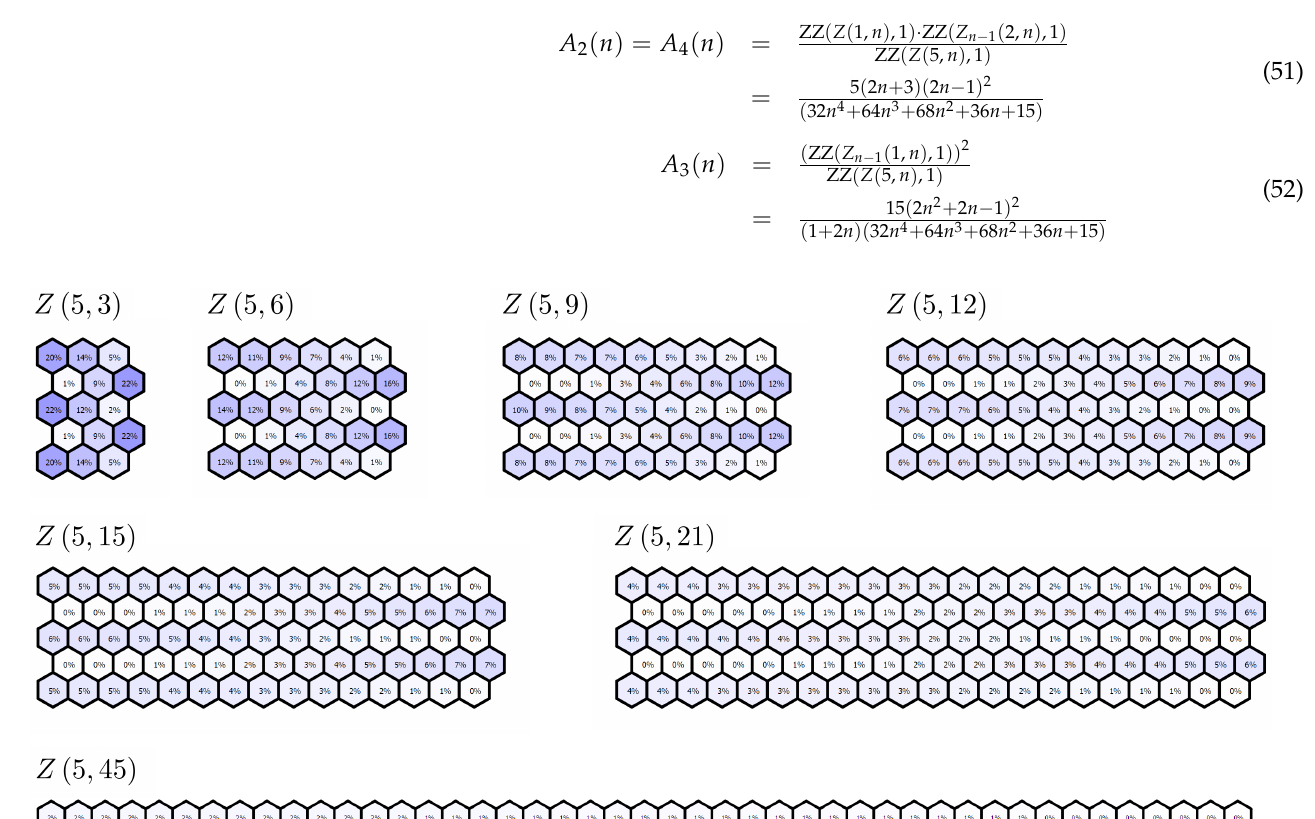
Figure 7. ZZ aromaticity indices computed for all the hexagons of multiple zigzag chains Z ( 5, n ) for n = 3,6, 9,12,15, 21, and 45. The positions of the most aromatic and most antiaromatic hexagons do not change with the length of Z ( 5, n ) , but the longer flakes loose almost all the aromaticity in comparison with an infinite graphene